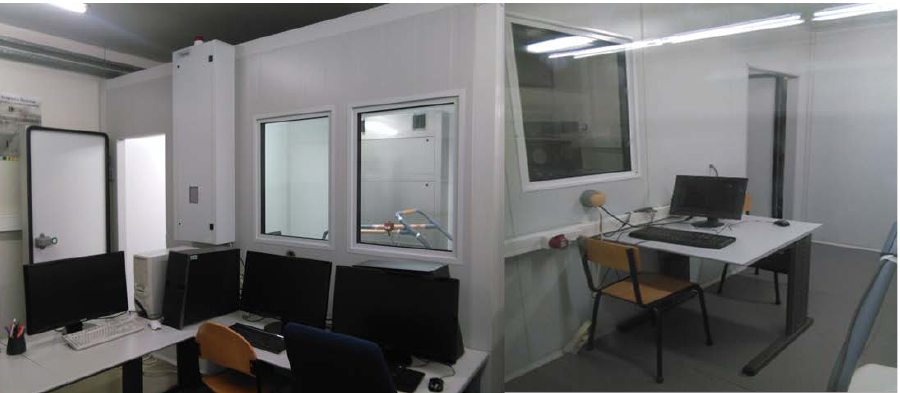
Figure 1. Outside (left) and inside (right) climatic